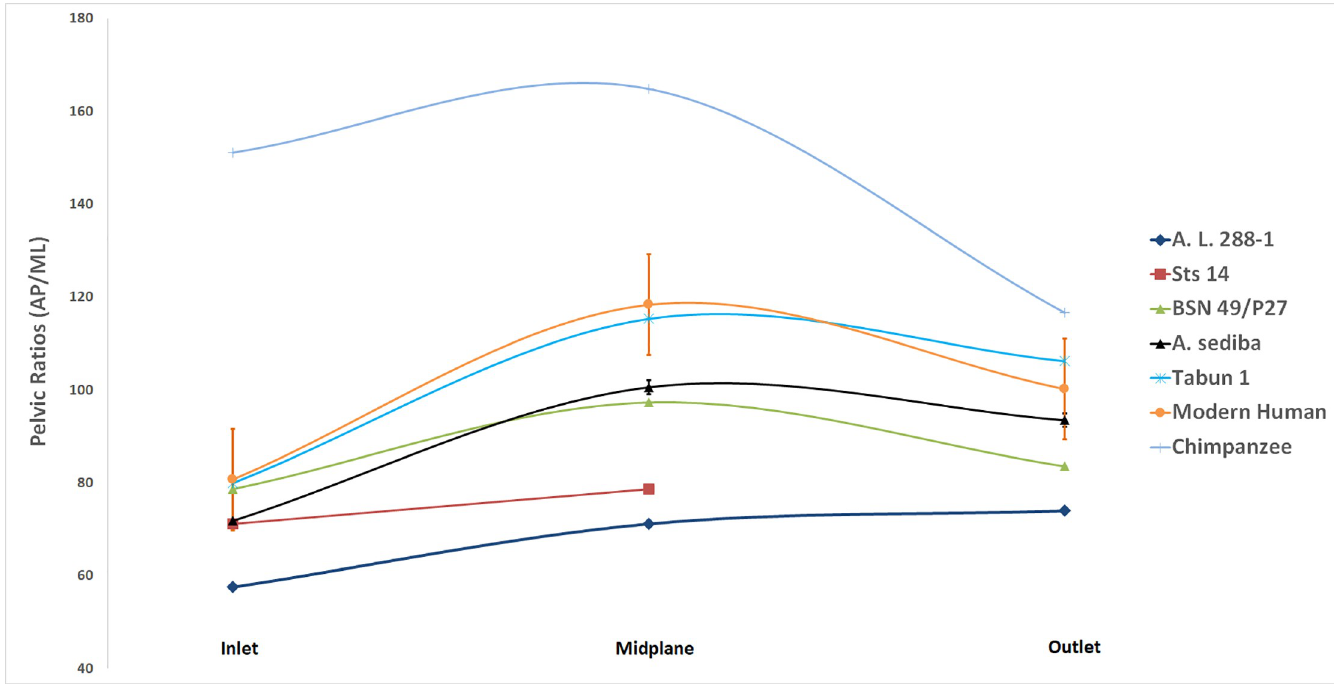
Fig 3. Pelvic indices (AP/ML) for hominin measures reported in Table 3. Notice that the chimpanzee pelvis remains AP elongated throughout the birth canal. Modern humans, in contrast, have a transversely oriented inlet that broadens (AP) at the midplane and becomes rounder at the outlet. Early australopiths (A.L. 288–1 and Sts 14) have transversely wide obstetric dimensions throughout. Notice, however, how similar the birth canal ratios of A . sediba are to BSN 49/P27, thought by many to belong to fossil Homo . The human values incorporate a range based on unpublished data provided by H. Kurki (n = 187, 1 standard deviation) and reported measures in Tague and Lovejoy [17], Simpson et al. [34], and Kibii et al. [42]. The A . sediba ranges are based on the different ischia (MH1, A.L. 288–1, Sts 14, and small-bodied human) that were used in the different composite pelves reconstructed. Notice that use of these different ischia does not significantly alter the estimated obstetric